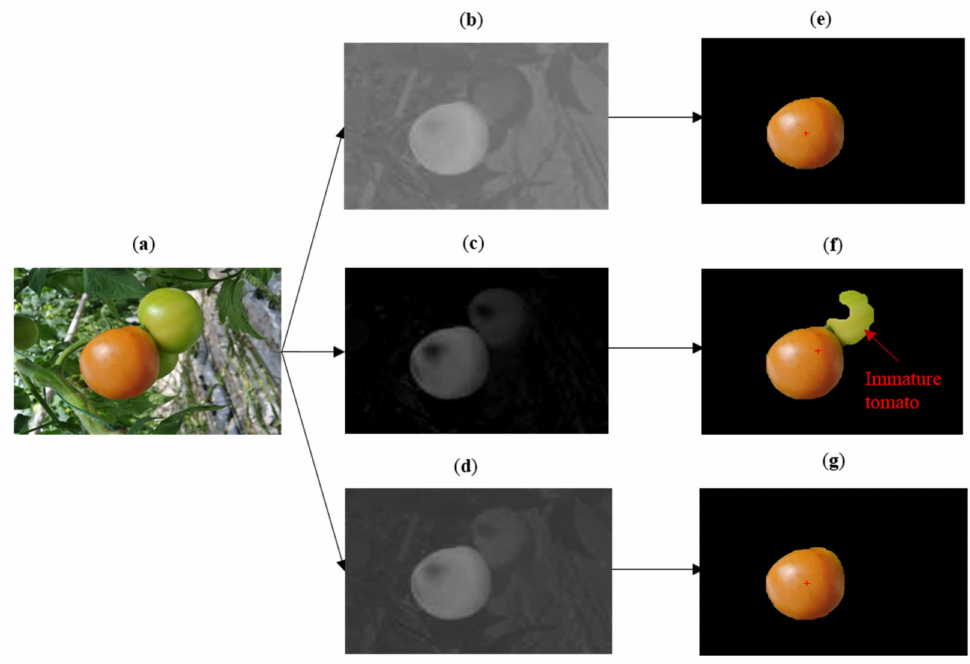
Figure 7. Contrast experiment about the disturbance of overlapping tomatoes. ( a ) Original image (tomatoes are overlapped in the image ); ( b ) a*-component image; ( c ) I-component image; ( d ) Fusion image of ( b ) and ( c ); ( e ) Recognition result of a*-component image; ( f ) Recognition result of I-component image; ( g ) Recognition result of fusion